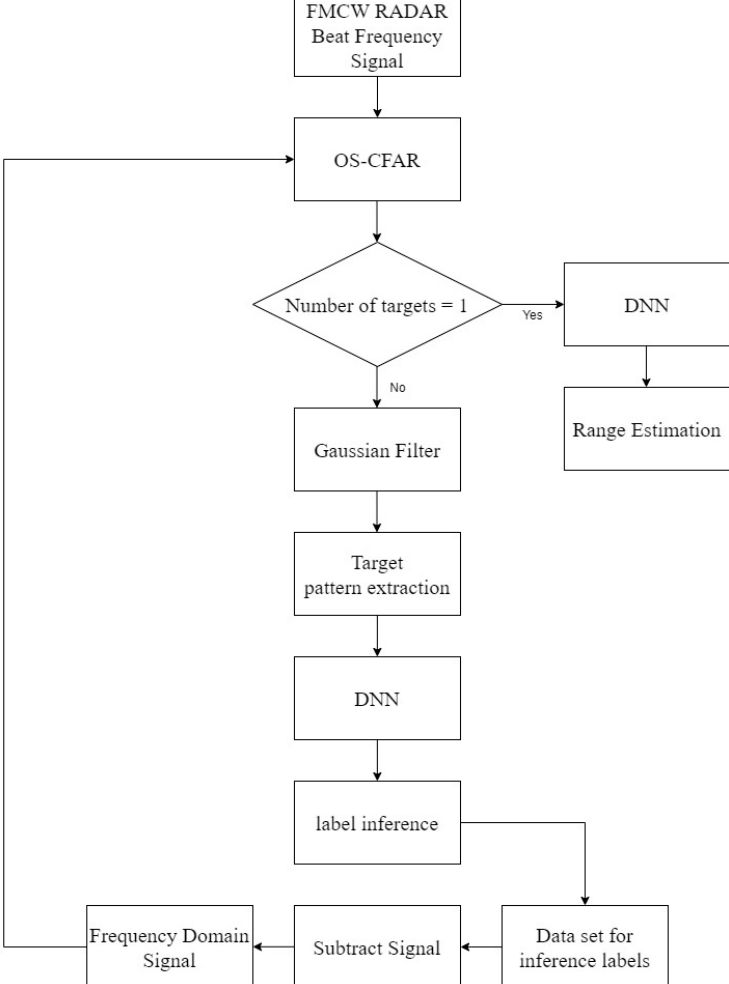
Figure 10. Algorithmic flowchart for multiple targets.